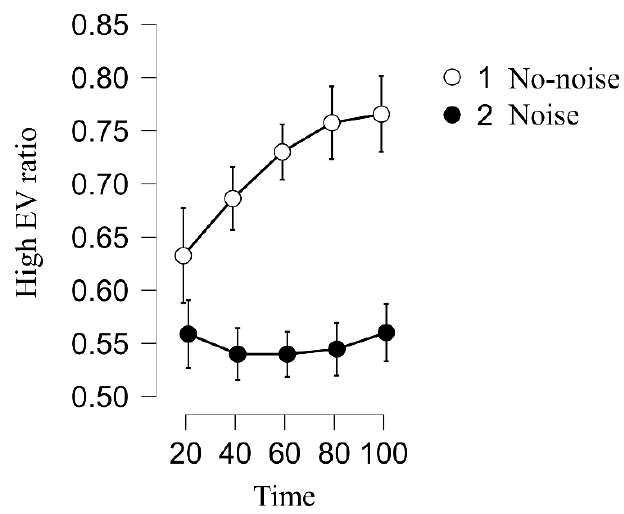
Figure 3. The trend of high-EV ratio in each condition over time of Study 1.